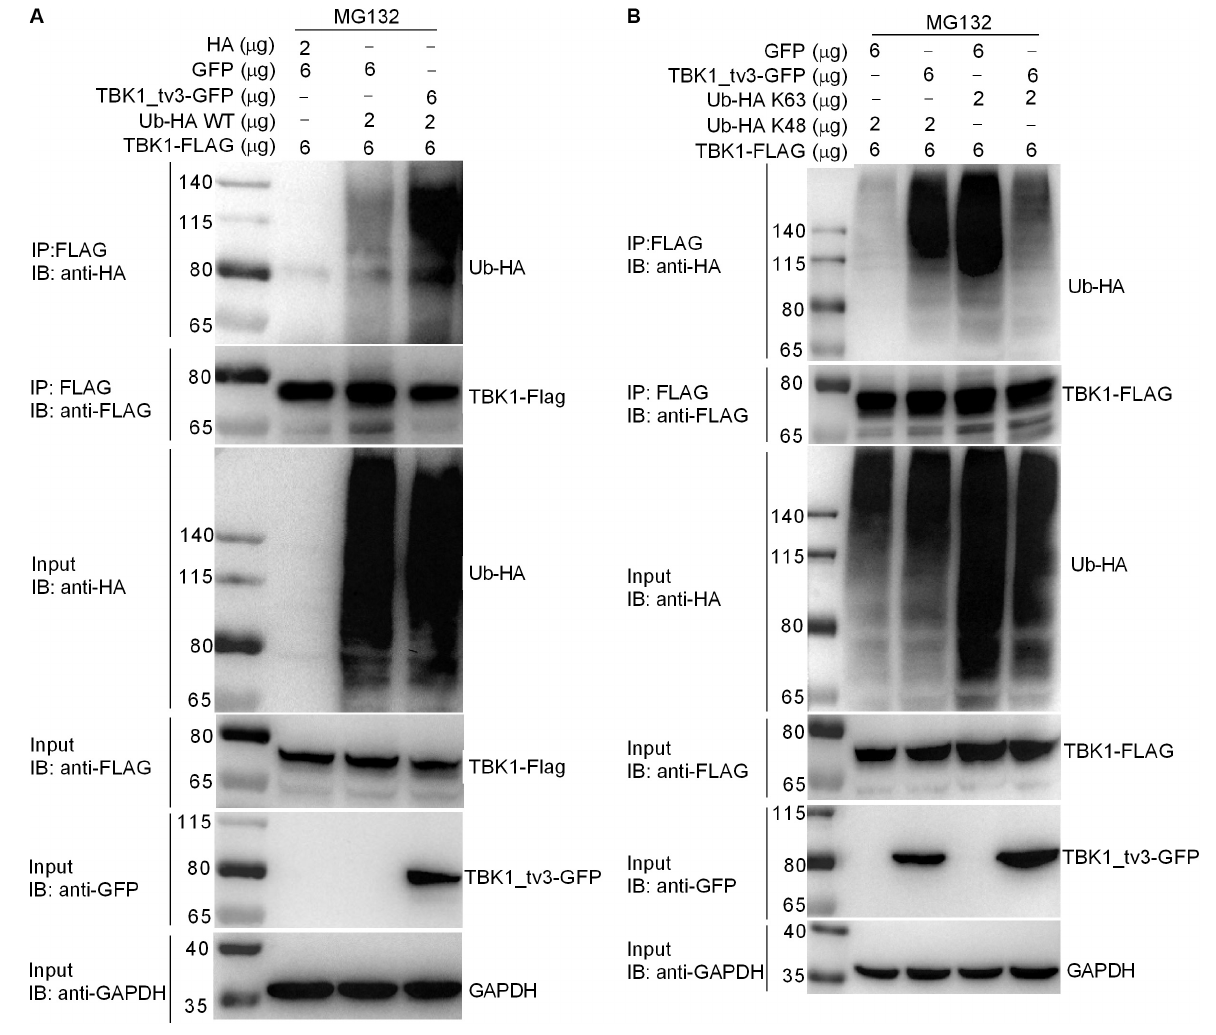
FIGURE 6 | TBK1_tv3 promotes K48-linked ubiquitination of TBK1. (A) TBK1_tv3 promotes the ubiquitination of TBK1. HEK 293T cells were seeded in 10-cm 2 dishes and transfected with 6 µ g TBK1-FLAG, 6 µ g TBK1_tv3-GFP, empty vector, and 2 µ g Ub-HA WT. At 18 h post-transfection, the cells were treated with MG132 for 6 h. Cell lysates were IP with anti-FLAG-conjugated agarose beads. The cell lysates and bound proteins were analyzed by immunoblotting with the indicated Abs. (B) TBK1_tv3 promotes the K48-linked ubiquitination of TBK1. HEK 293T cells were seeded in 10-cm 2 dishes and transfected with 6 µ g TBK1-FLAG, 6 µ g TBK1_tv3-GFP, empty vector, 2 µ g Ub-HA K48, or 2 µ g Ub-HA K63. At 18 h post-transfection, the cells were treated with MG132 for 6 h. Cell lysates were IP with anti-FLAG-conjugated agarose beads. The cell lysates and bound proteins were analyzed by immunoblotting with the indicated Abs. All experiments were repeated for at least three times with similar